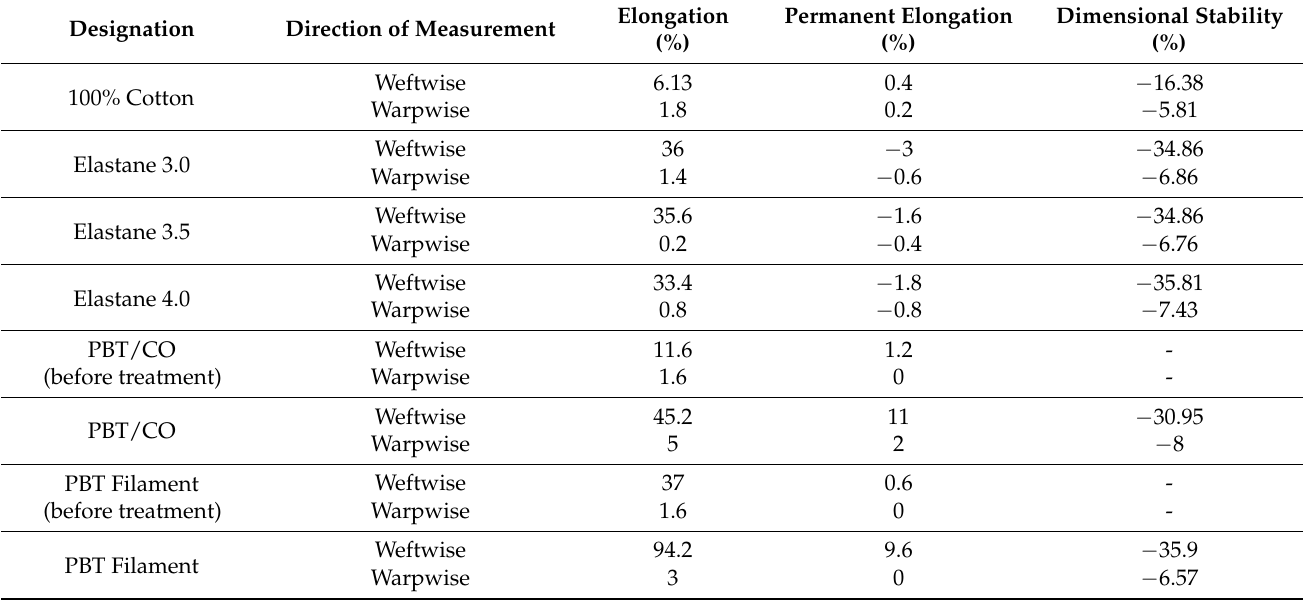
Table A2. The elongation and dimensional stability values of the fabric samples.